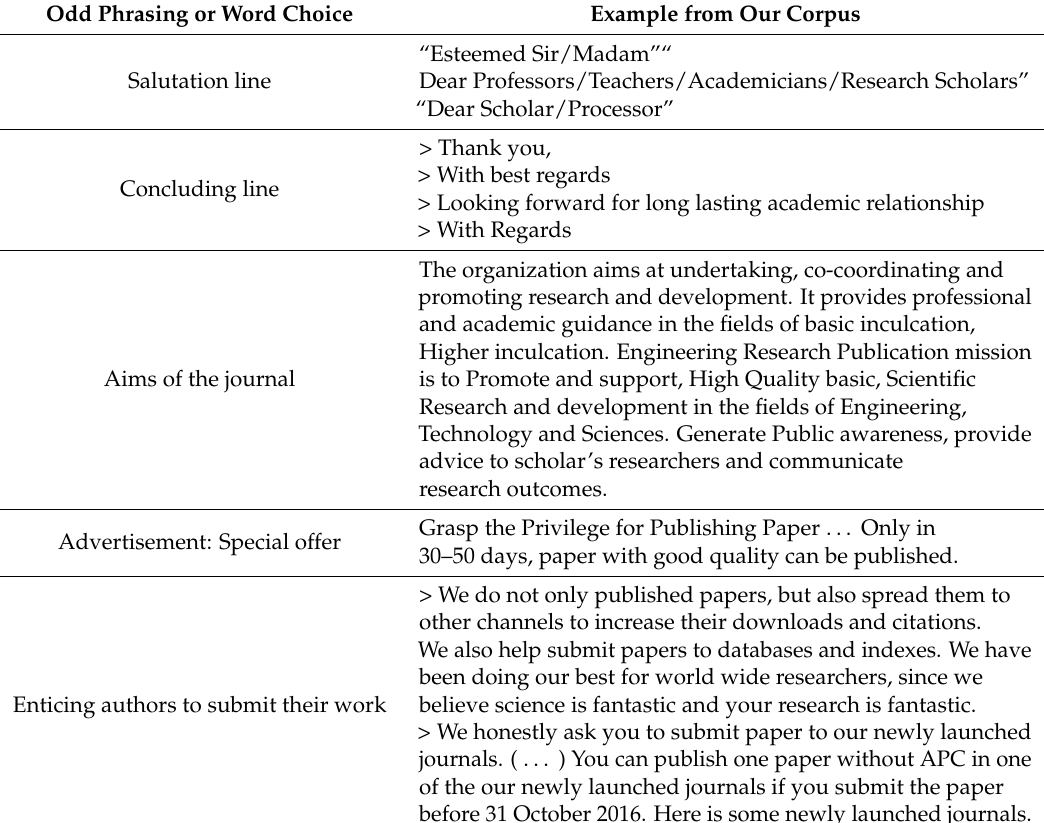
Table 3. Examples of fine-grained lexical and grammatical issues, and odd